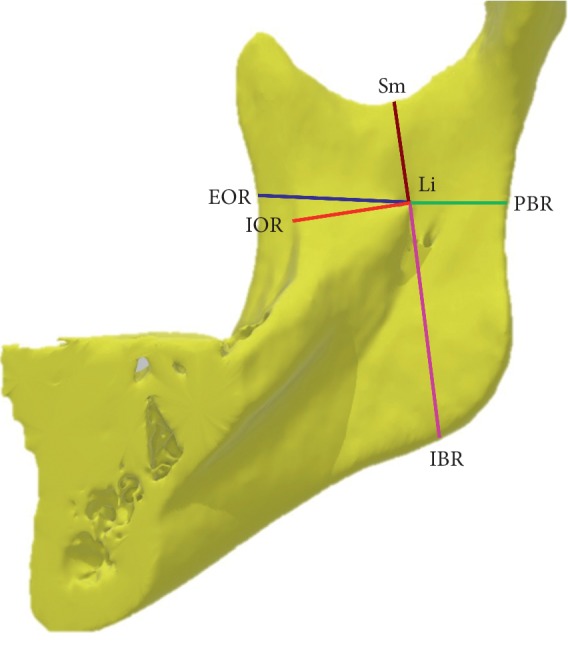
Location of the mandibular lingula. Measured reference points for lingula tip (Li). External oblique ridge (EOR), internal oblique ridge (IOR), sigmoid notch (Sm). Posterior border of ramus (PBR) and Inferior border of ramus (IBR).